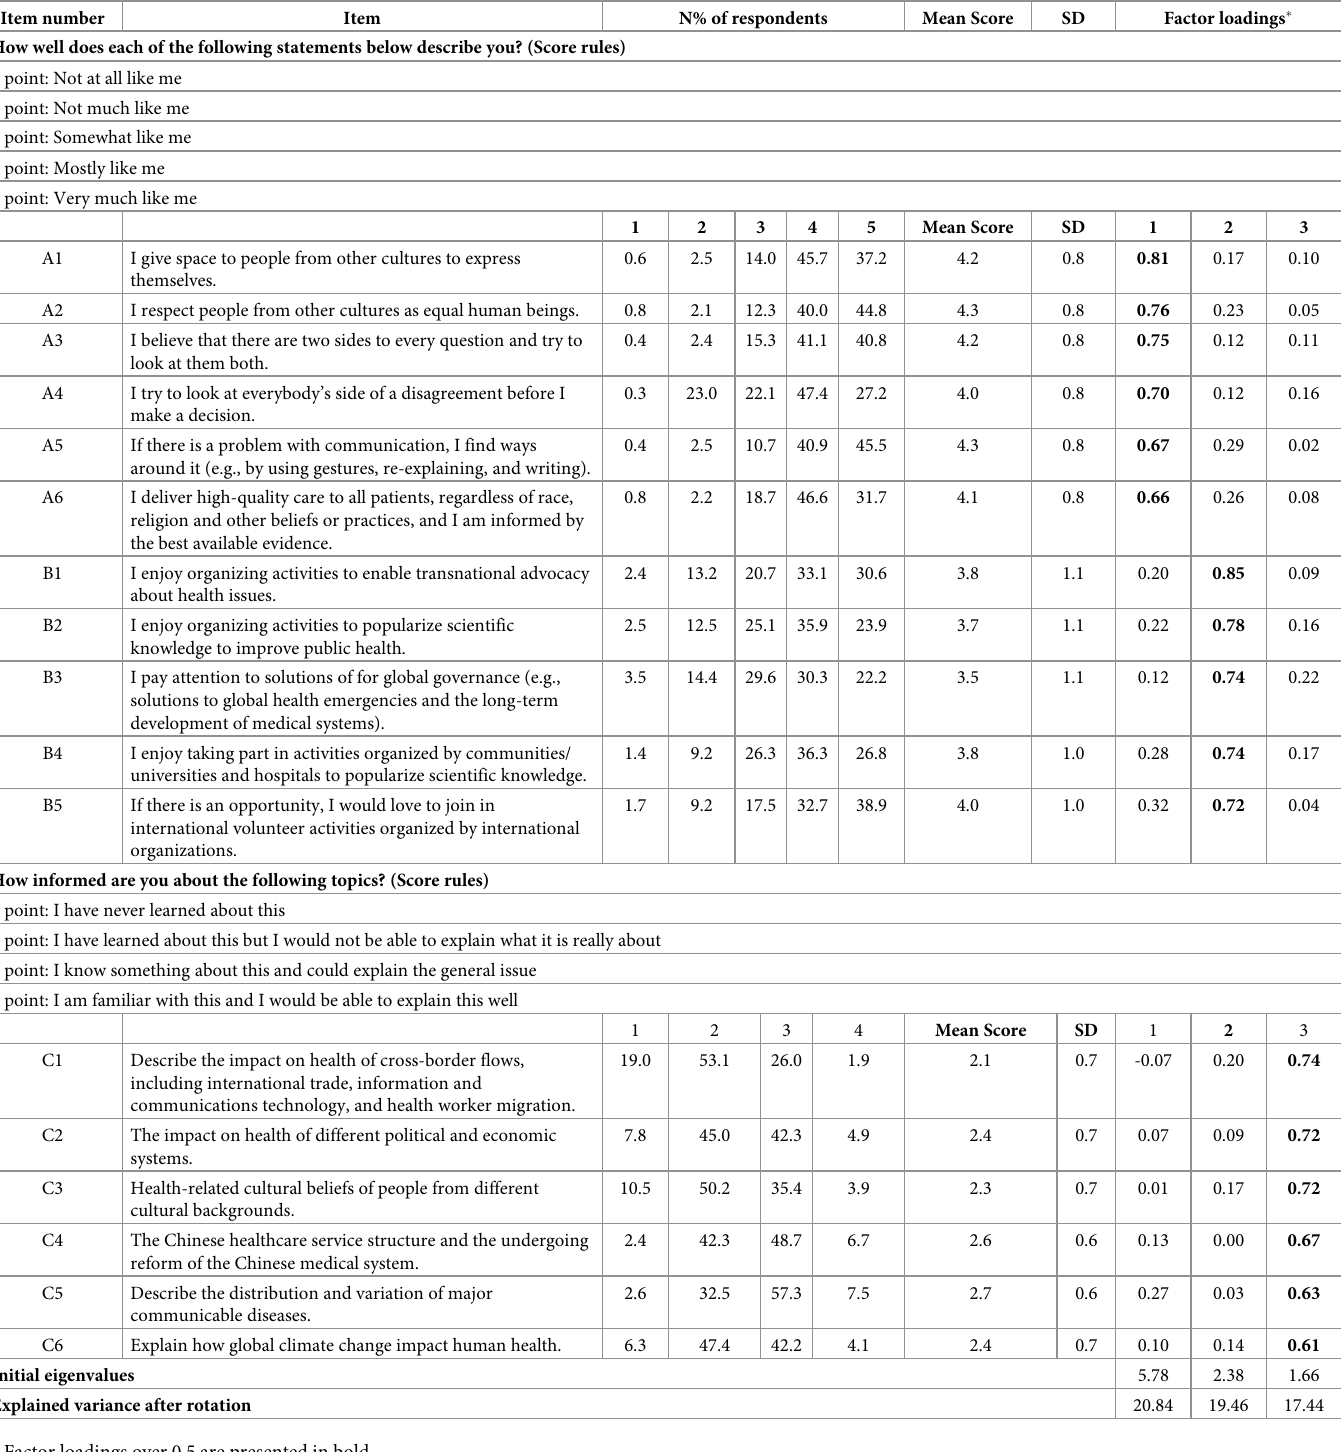
Table 2. The results of exploratory factor analysis of the MS-GCAS. Item number Item N% of respondents Mean Score SD Factor loadings